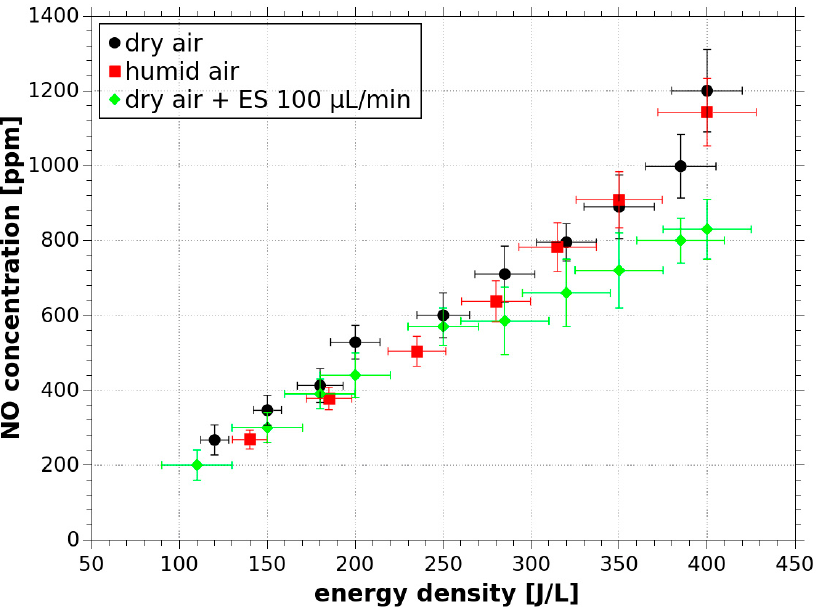
Figure 6. NO concentration as a function of the TS input energy density, measured by UV-Vis absorption technique, short absorption cell, 1SS.